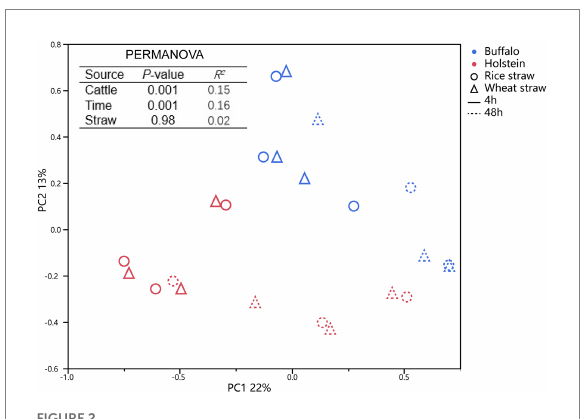
FIGURE 2 Principal coordinate analysis of bacterial community attached to rice and wheat straws at 4 and 48 h of in situ incubation time in buffalo and Holstein rumen. PERMANOVA, permutational multivariate analysis of